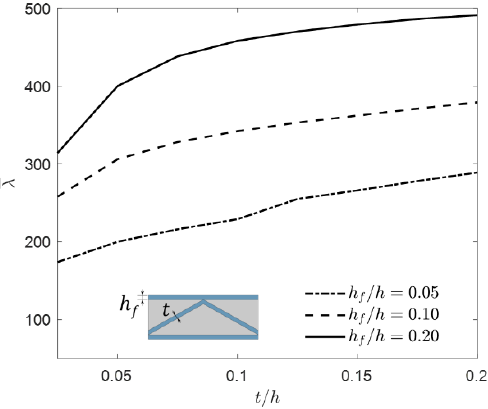
Figure 12. Effect of thickness of face sheets and corrugated members on dimensionless critical dynamic pressure with temperature change Δ T = 100.